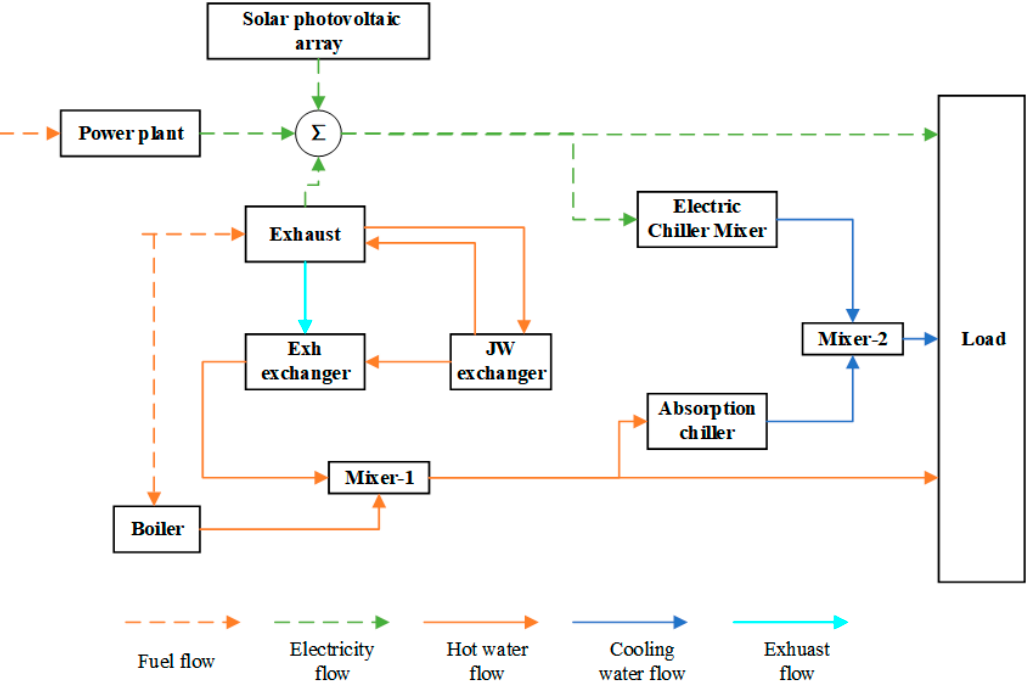
Figure 2. Structure of a CCHP system.